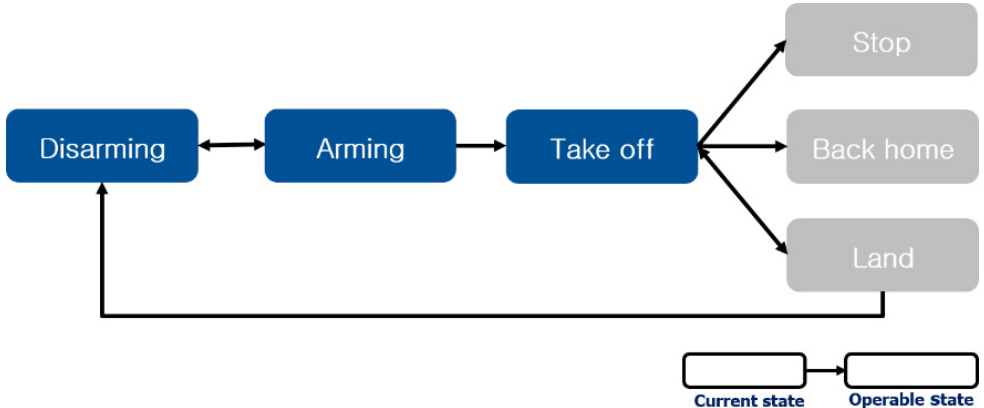
Figure 8. Graph of the relationship between the static gesture commands.